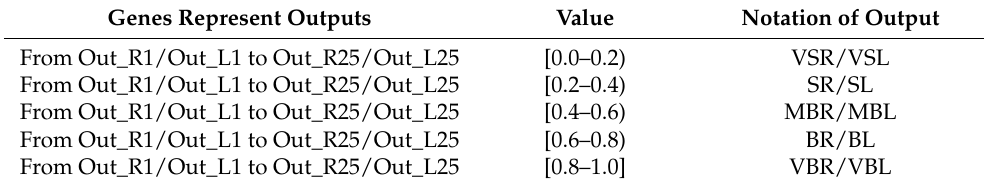
Table 9. The mapping of genes into the notations of the output membership functions.